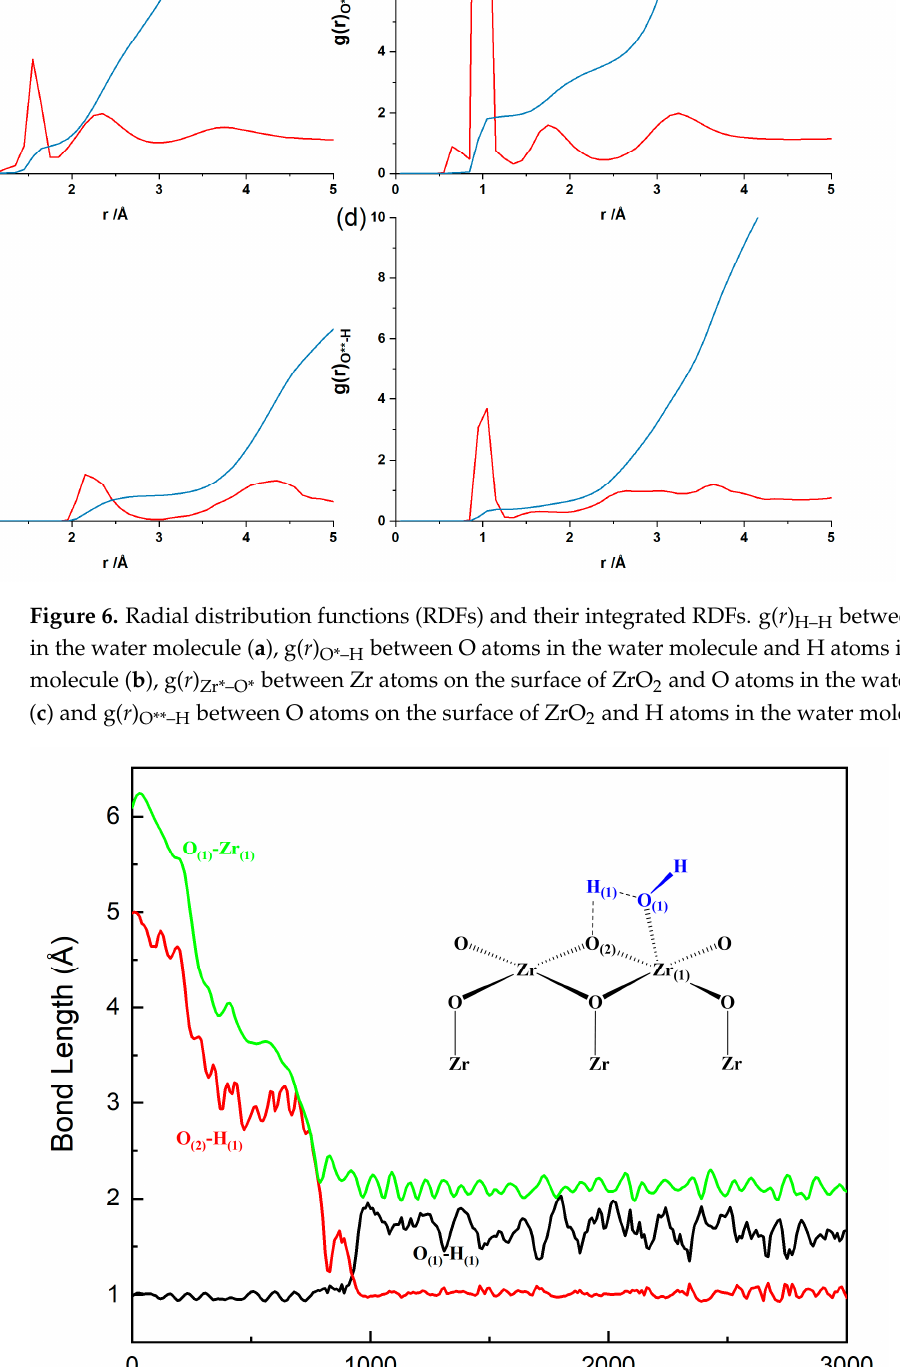
Figure 8. FPMD simulation snapshots at 0 ( a ), 1000 ( b ) and 3000 fs ( c ) of the water–solid interface reaction of ZrO 2 at site A .